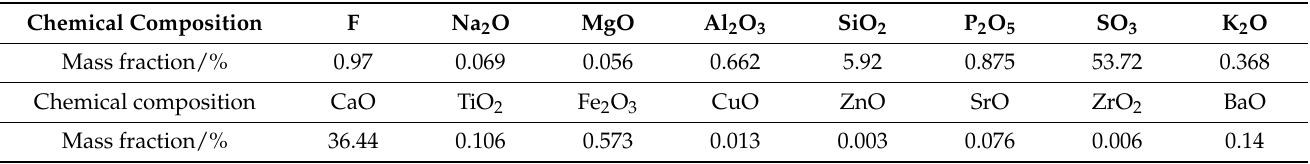
Table 1. Chemical composition of